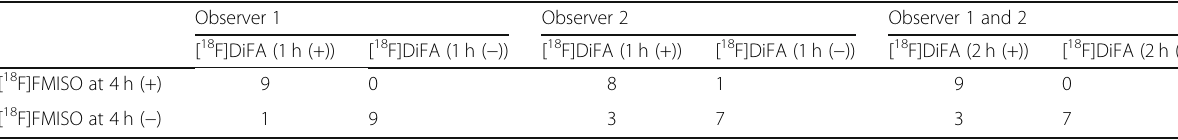
Table 5 Performance of [ 18 F]DiFA in detecting hypoxia compared to [ 18 F]FMISO at 4